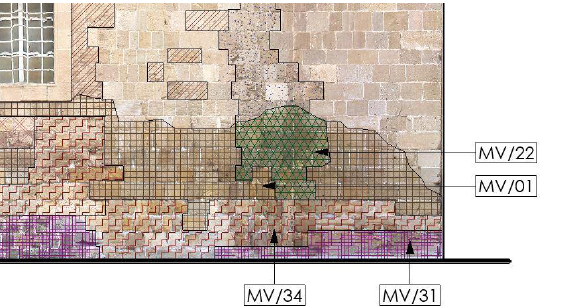
Figure 20. Decays mapping with codes and parametric “filled regions”